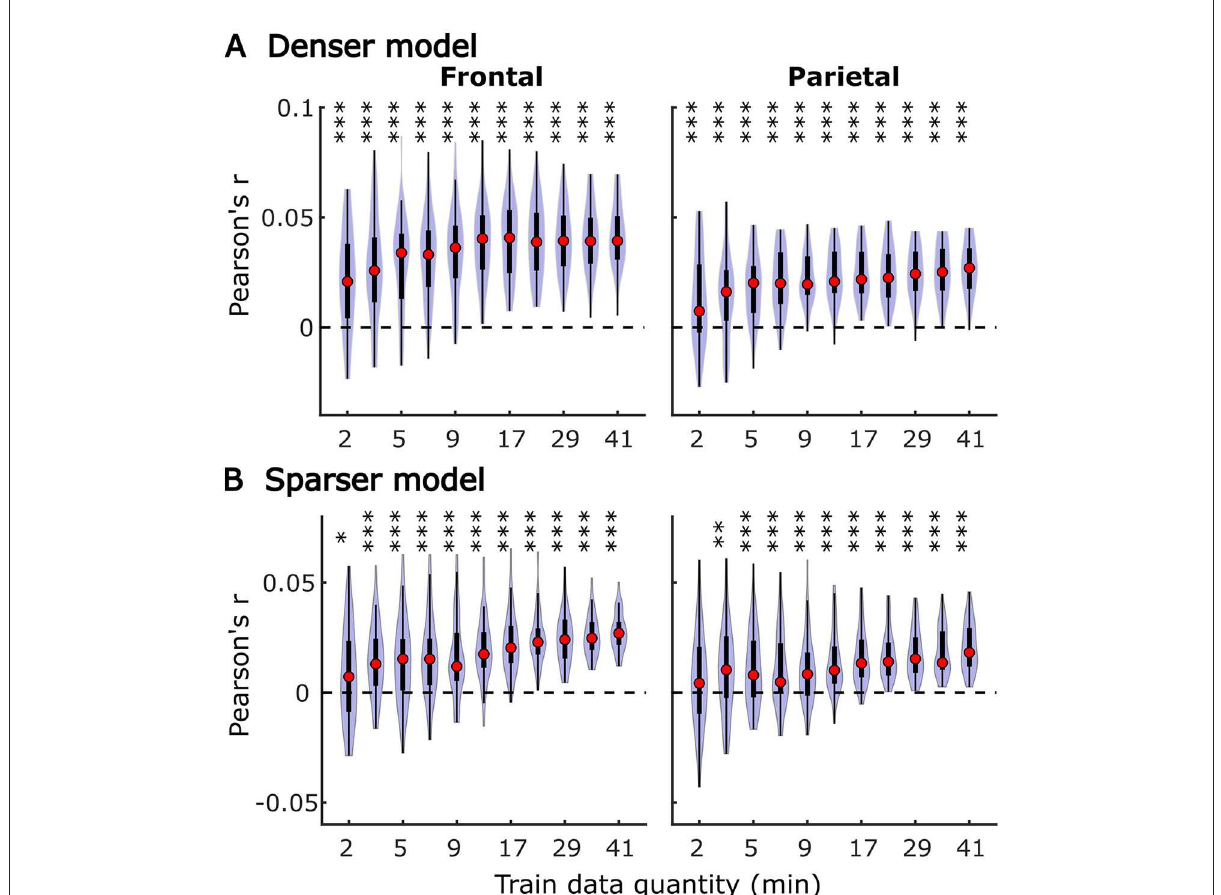
FIGURE1 Overall subject-specific model prediction accuracies for the denser ( A ; onset and envelope features) and sparser ( B ; onset, surprisal, and SNR word features) models displayed as a function of training data quantity (data acquisition duration). The violin plots depict the distribution of these values for all 41 participants, with a box plot depiction (interquartile range) shown within each violin. Red circles denote median values of the distributions. The uncorrected significance levels of each statical comparison against zero are displayed at the top of each plot: * p < 0.05, ** p < 0.01, *** p < 0.001. To improve readability, the significance markers are offset slightly to the left of their respective